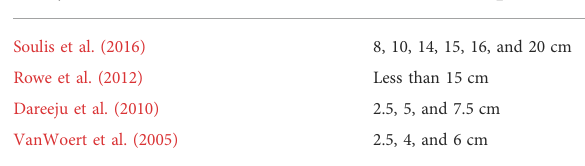
TABLE 2 Preceded studies on substrate